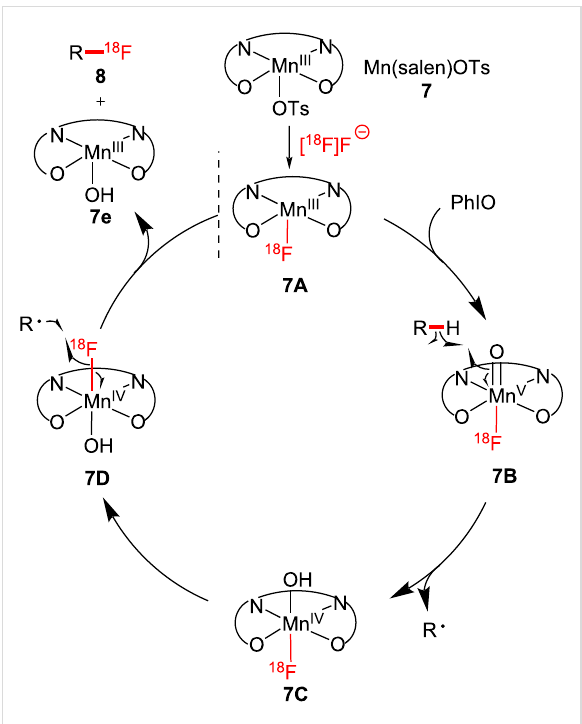
Figure 2: Proposed mechanism of C–H